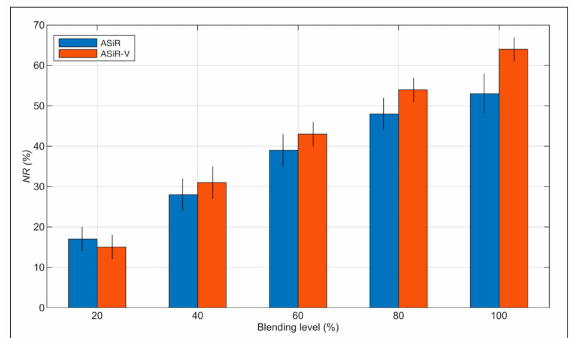
Figure 6. CTP486 homogeneous phantom module. Noise reduction properties of ASiR-V and ASiR reconstruction algorithms with respect to conventional FBP, NR(%) , estimated as the mean (SD) value of PDN-ASiR-V and PDN-ASiR-V maps within a central circular ROI of 1 cm diameter.